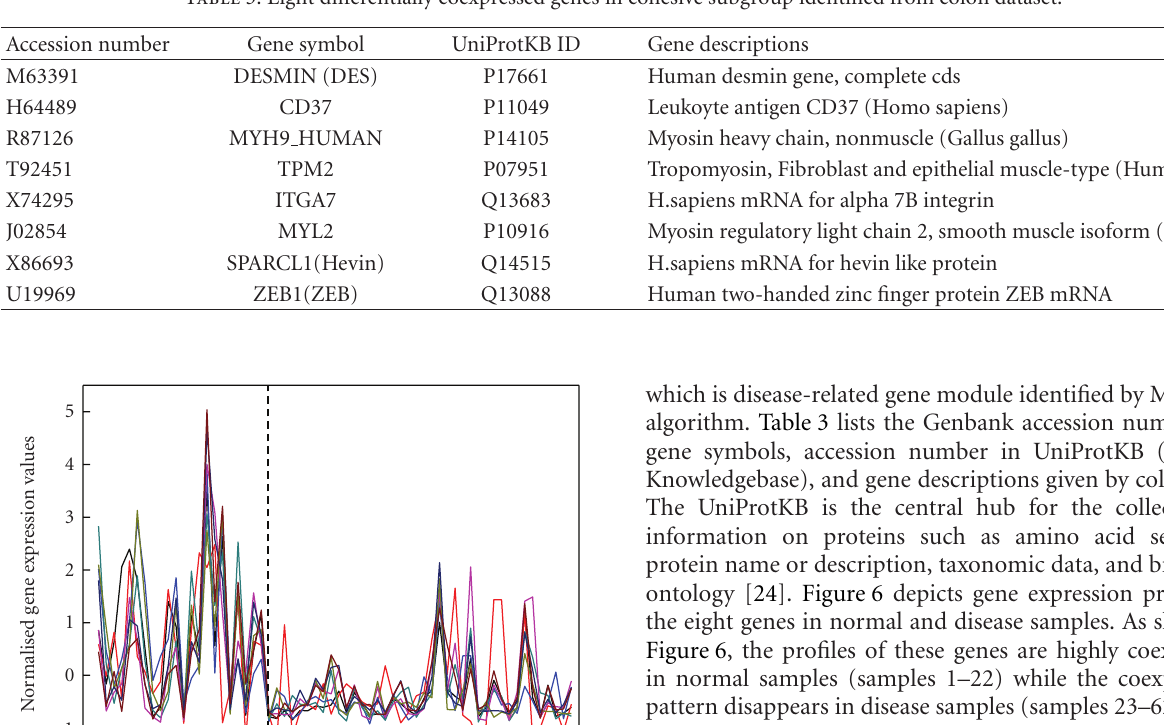
Table 3: Eight di ff erentially coexpressed genes in cohesive subgroup identified from colon dataset.